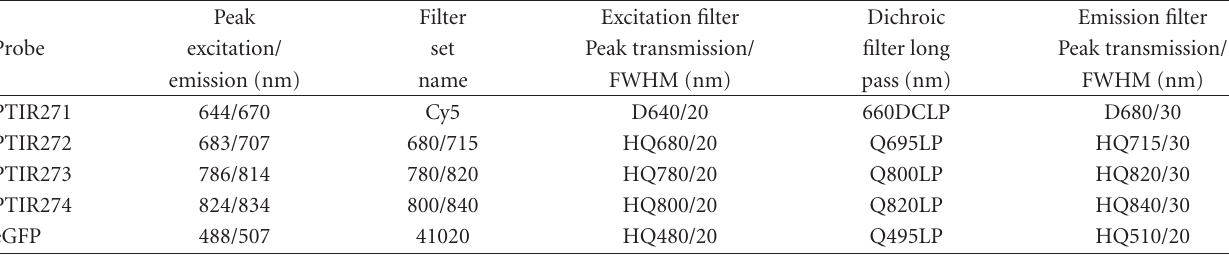
Table 1: Characteristics of the far-red and near-infrared fluorescence probes and corresponding Chroma Technologies filter sets for mi- croscopy. Bandpass filter sets Cy5 (for PTIR271) and 41020 (for eGFP) are o ff -the-shelf filters from Chroma Technologies. Sets for PTIR272 to PTIR274 were custom manufactured by Chroma. Their names indicate peak excitation/emission wavelengths. FWHM indicates full width of transmission band at half intensity of maximum